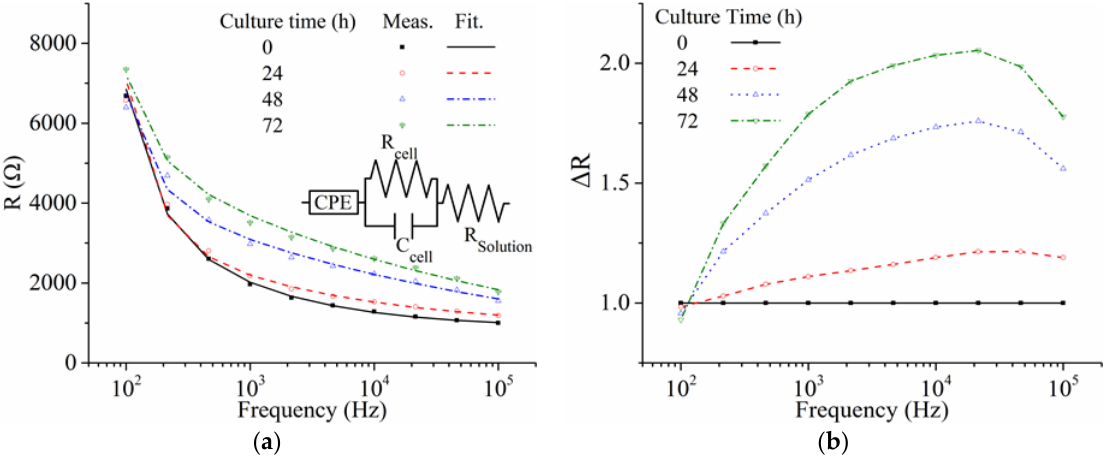
Figure 6. ( a ) Resistance (R) of C2C12 cells on the ITO electrode measured during cell growth, together with fitted lines using the established equivalent circuit model [34] and ( b ) resistance change (ΔR = R/R at 0 h).